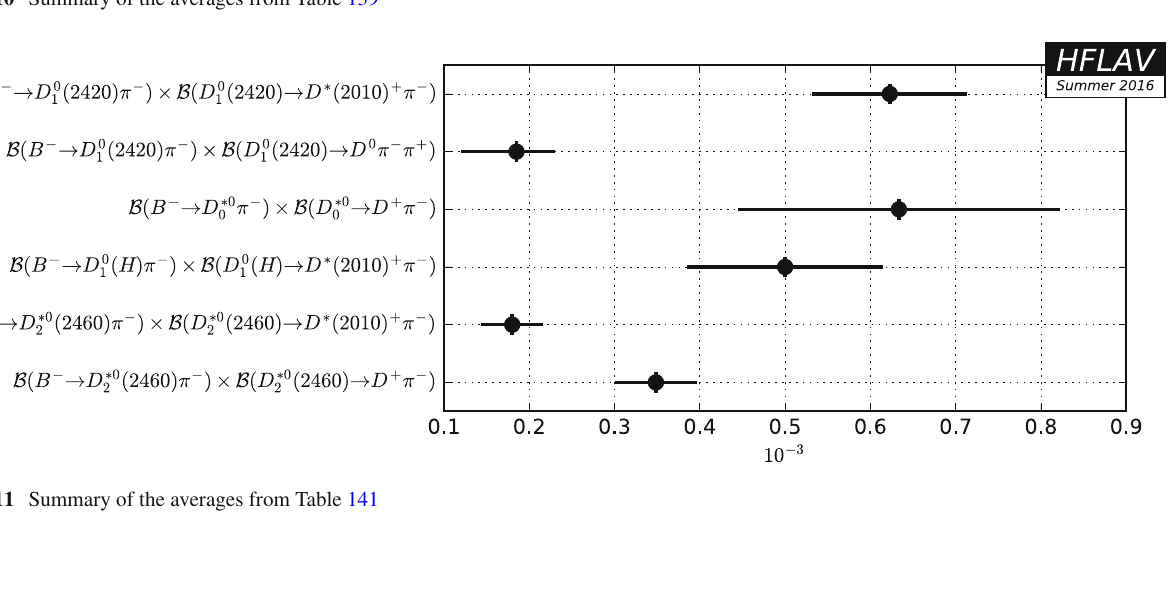
Fig. 110 Summary of the averages from Table 139